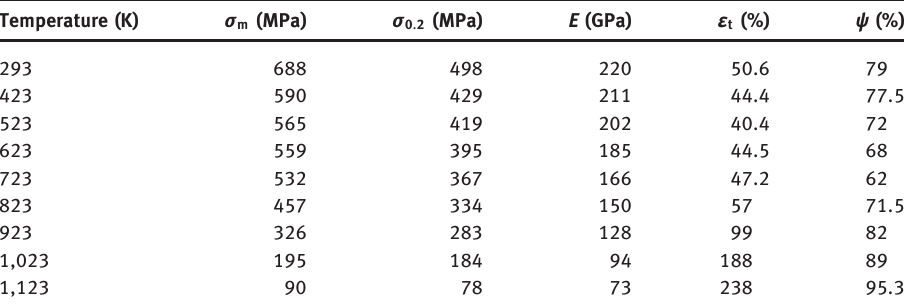
Table 1: Numerical values of material properties at different temperatures – steel 1.4841.